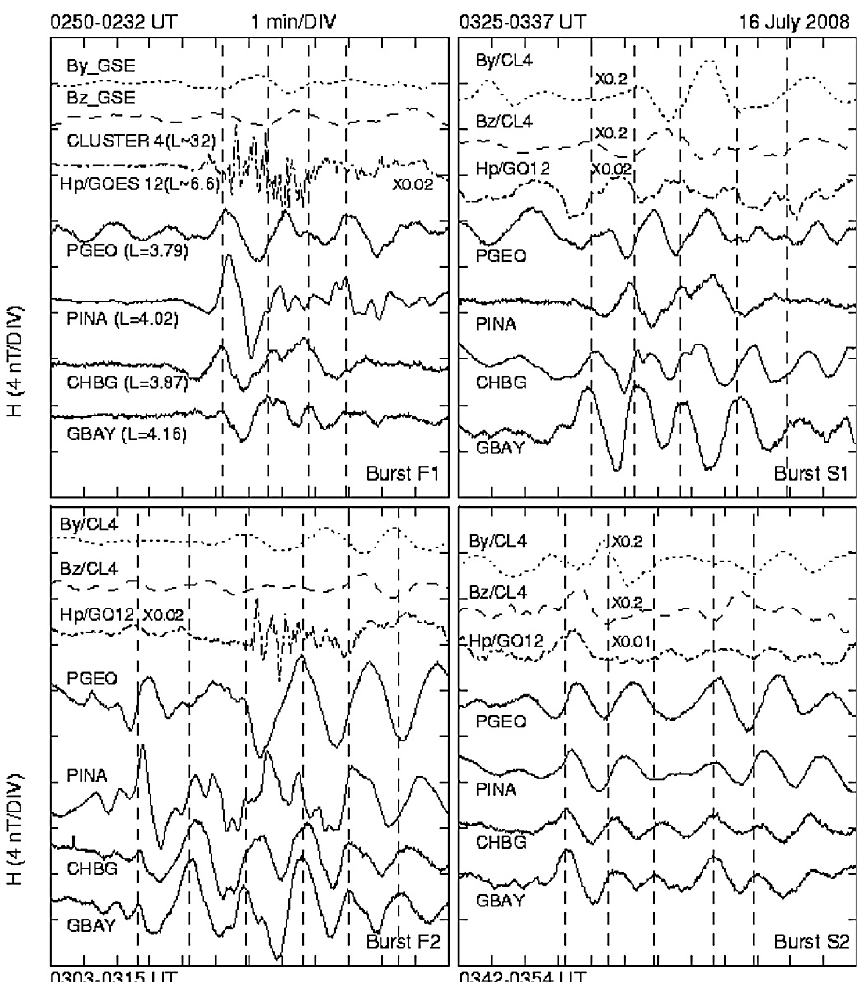
Fig. 16. Waveforms for the mid- L stations near L = 4. Comments of caption to Fig. 15